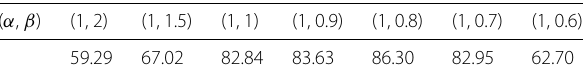
Table 8 Classification accuracy (%) of conv 5 for different α and β